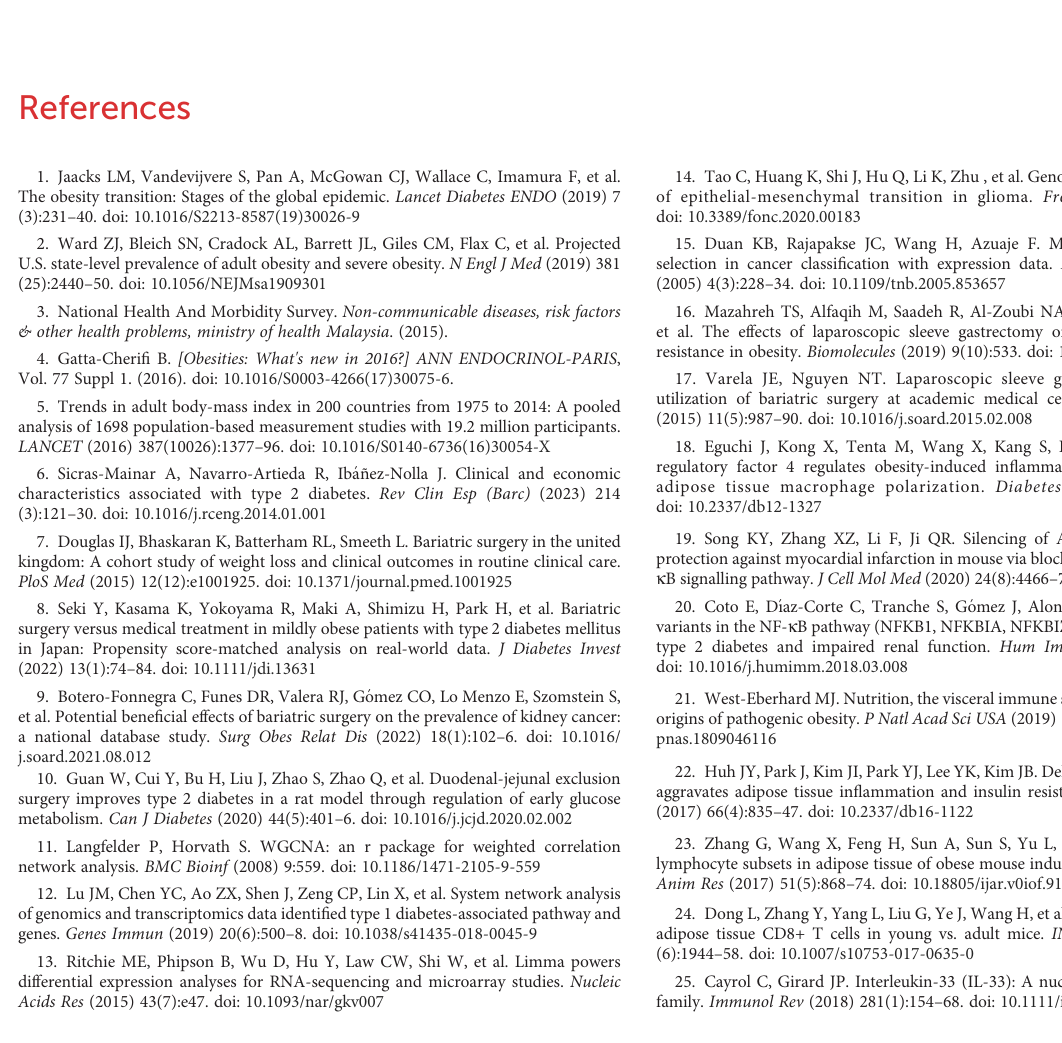
SUPPLEMENTARY TABLE 10 22 DE-lncRNAs between obese patients before and after LSG treatment. SUPPLEMENTARY TABLE 11 The ceRNA regulatory network of three